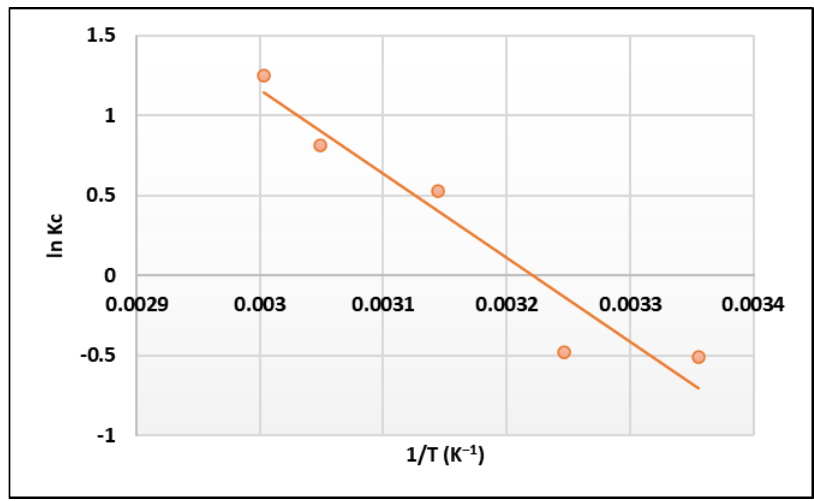
Figure 14. CR dye adsorption thermodynamic onto 2Clph-BU-Cs adsorbent.